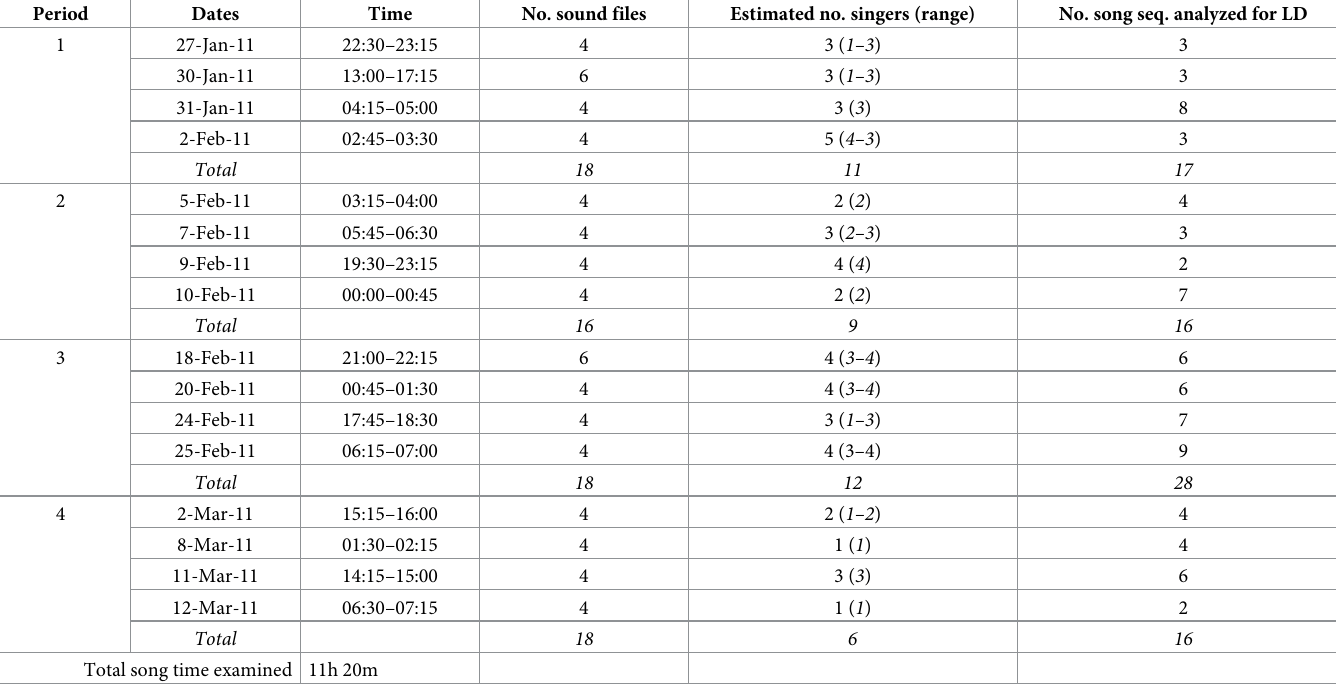
Table 1. A summary of the analyzed